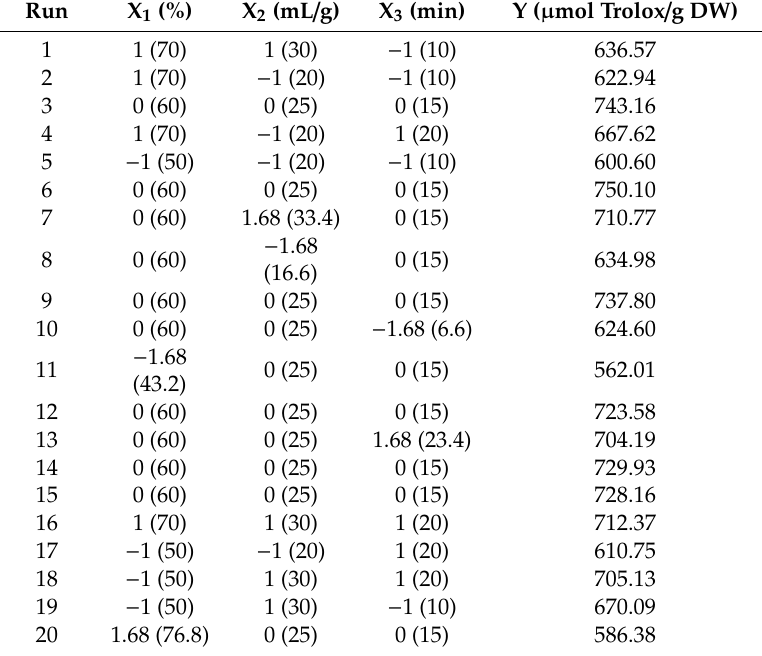
Table 1. Response surface design and Trolox equivalent antioxidant capacity (TEAC) values of the extracts. DW—dry